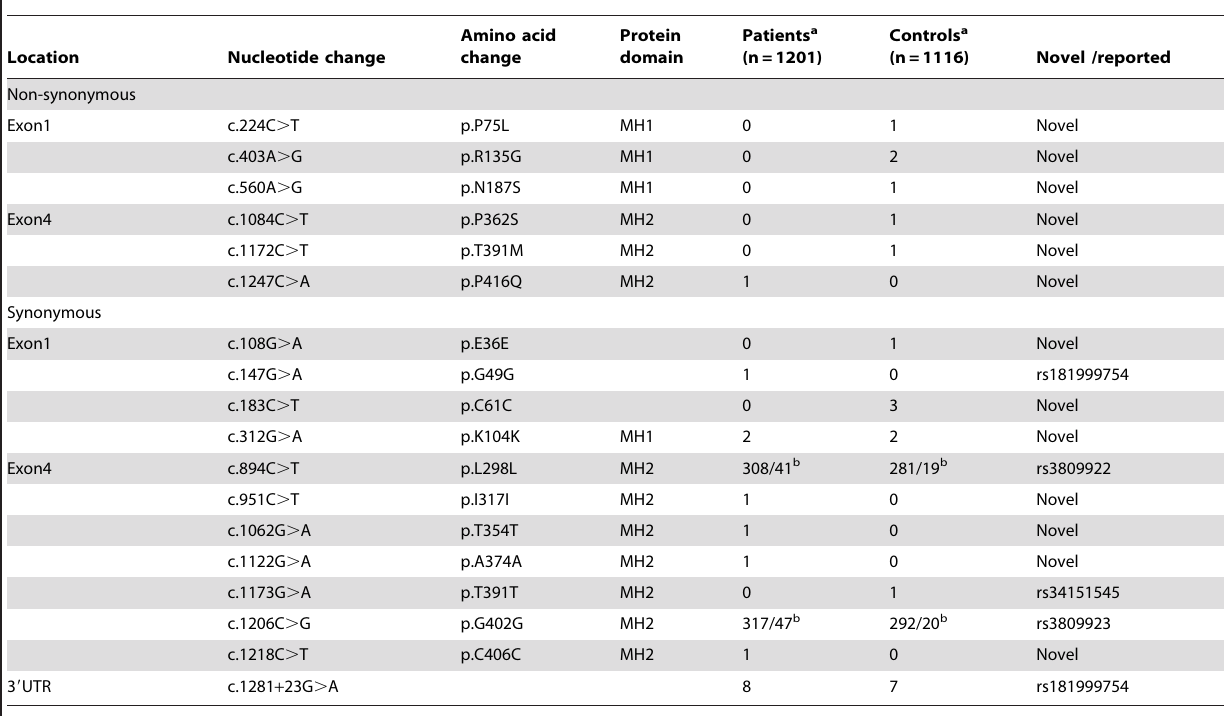
Table 1. SMAD7 sequence variants identified in CHD and control subjects.